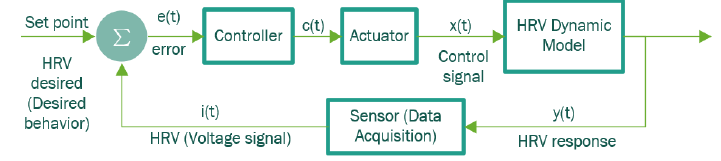
Figure 1. Biofeedback Control